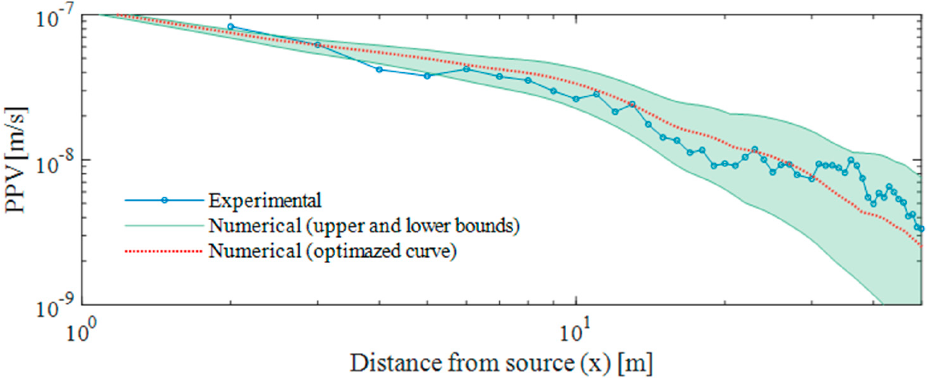
Figure 12. Peak particle velocity versus distance from the pile due to Ricker pulse: experimental (blue line) vs numerical results (red line— ξ = 0.05 ( first layer ) ; 0.025 ( remaining layers ) ; upper bound— 𝜉 (cid:2869) = 0.01 ; lower bound— 𝜉 (cid:2870) = 0.05 ).